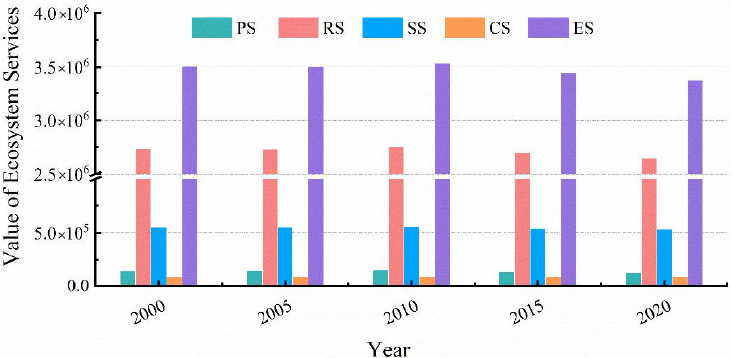
Figure 4. Ecosystem service values in Ruijin City from 2000 to 2020 (unit: ten thousand Yuan).